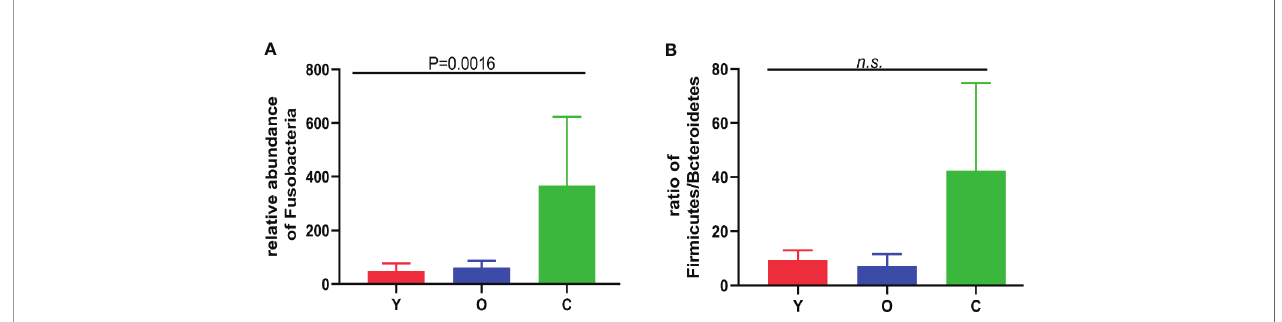
FIGURE 3 | (A) the relative abundance of the Fusobacterium among the three groups. (B) the Firmicutes/Bacteroidetes ratio among the three groups. n.s, no signi